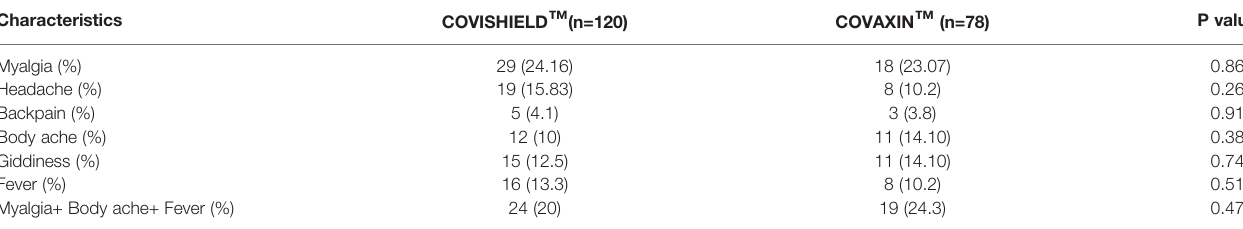
TABLE 6 | Side effects associated with vaccination.